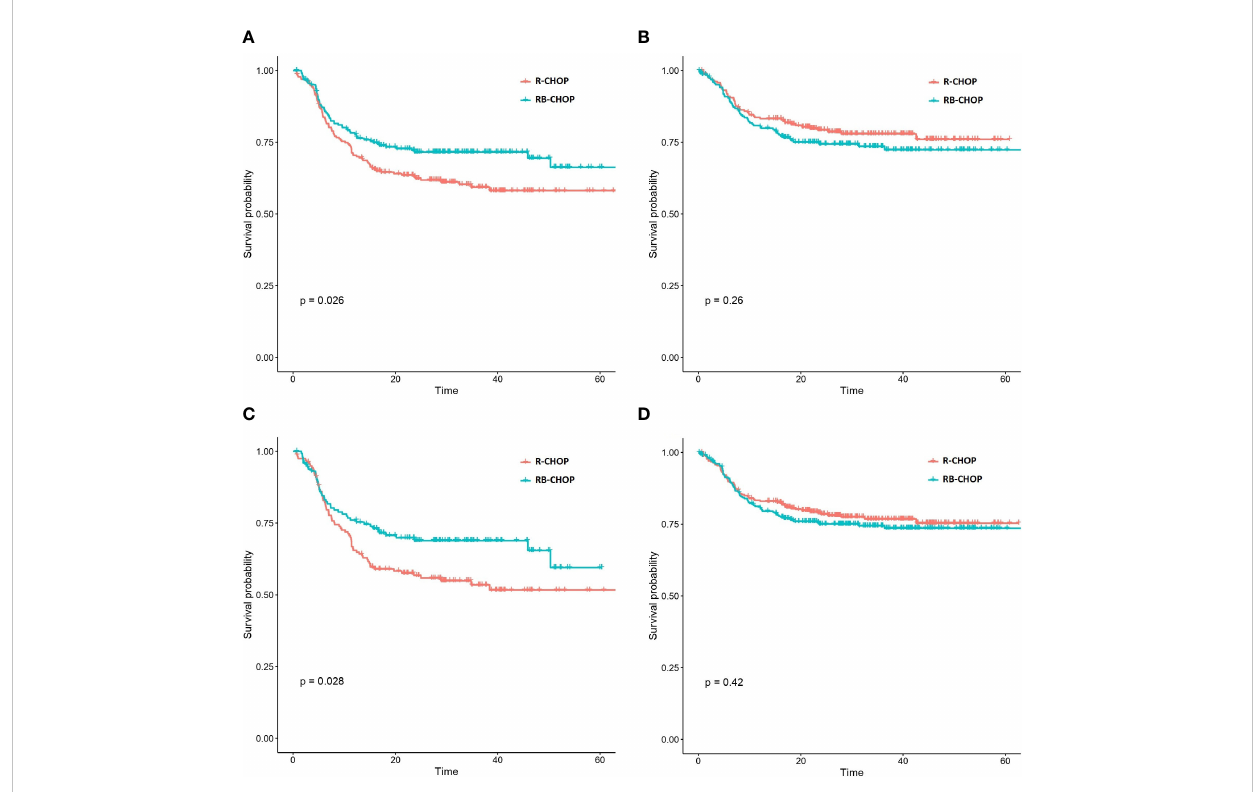
FIGURE 1 Kaplan-Meier curves representing the PFS of patients treated with RB-CHOP and R-CHOP according to their biological risk predicted by the CD3 markers & 17 gene expression signature. (A, B) Representation of RB-CHOP and R-CHOP curves for those patients in the higher 50% risk group (A) and in the lower 50%risk group (B) . (C, D) Representation of RB-CHOP and R-CHOP curves for those patients in the higher 33% risk group (A) and in the lower 67%risk group (B)